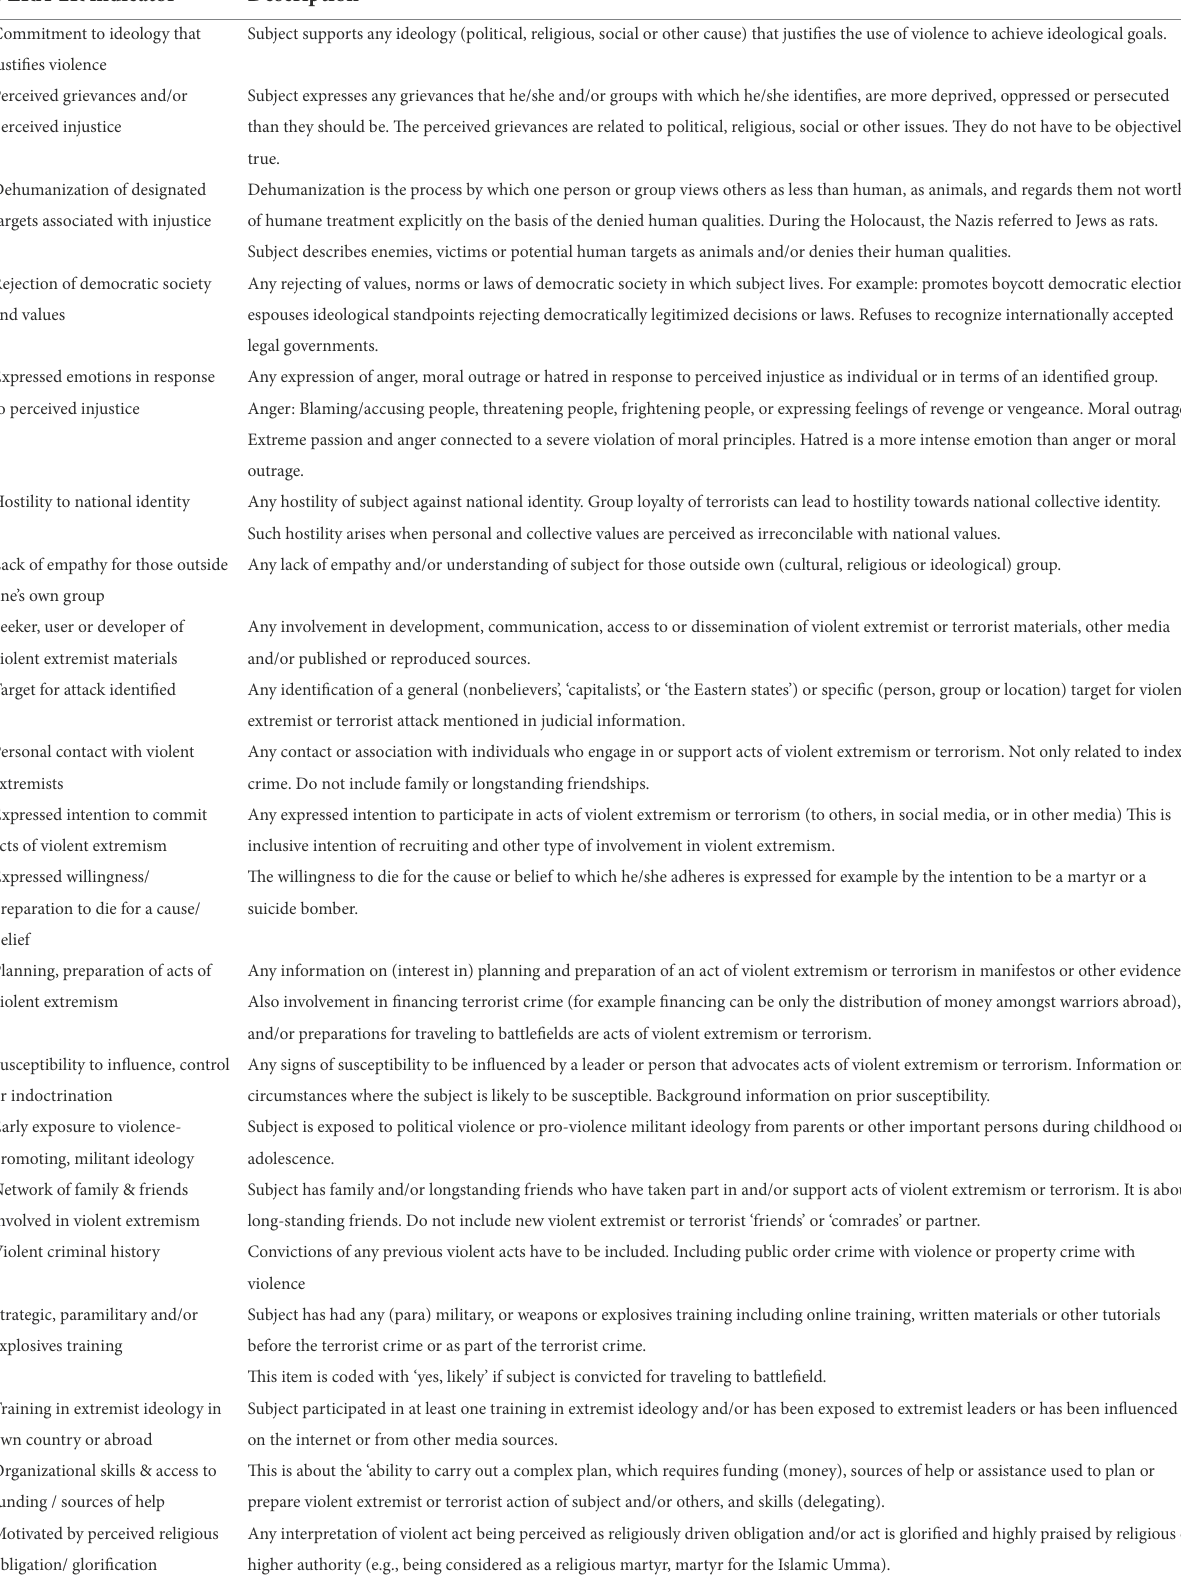
TABLE 1 The European Database of Terrorist offenders: Overview of the indicators of the VERA-2R domains. VERA-2R indicator